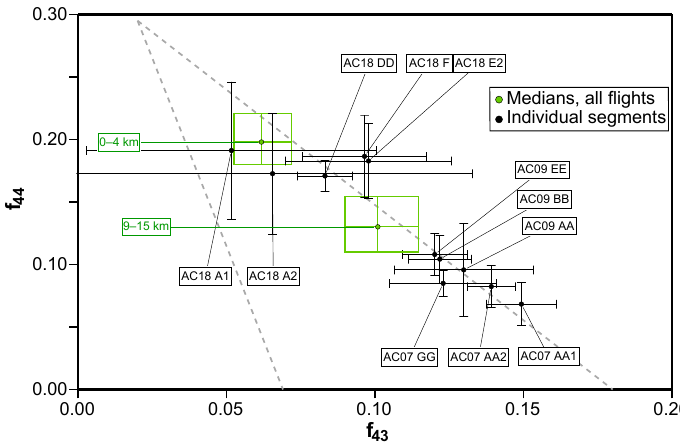
Figure 17. Plot of the AMS factors f 44 vs. f 43 , indicating the median values for the LT and UT and values for some UT flight segments with elevated aerosol concentrations. With increasing degree of oxidation, the measurements move to the upper left of the